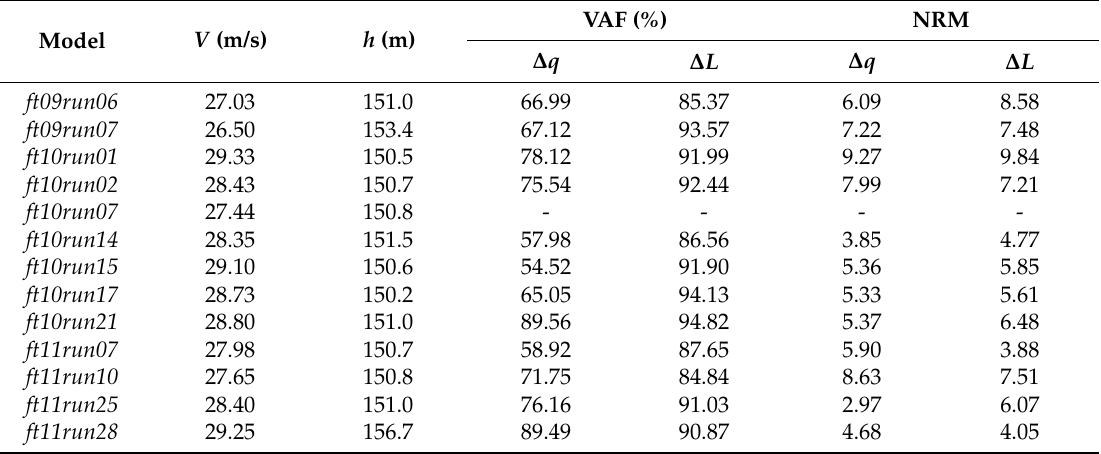
Figure 6. Model ft10run07 cross ‐ validated with data ft10run15 . Table 1. Cross ‐ validation of model ft10run07 with other flight data. VAF, variance accounted for; NRM, norm.